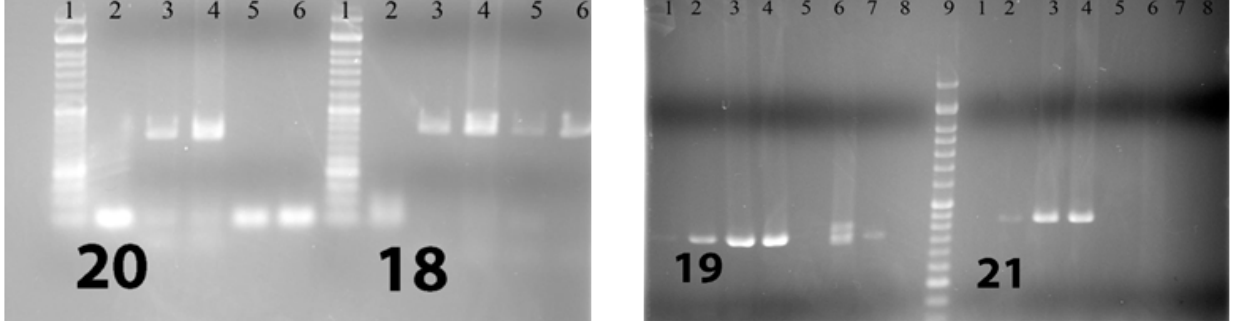
Figure 2 . Visualized product on electrophoresis gel for simple PCR (first run) of exons 19 and 21. 1, 2, 3, 4, 5, 6, 7: Patients 8: Negative control 9: